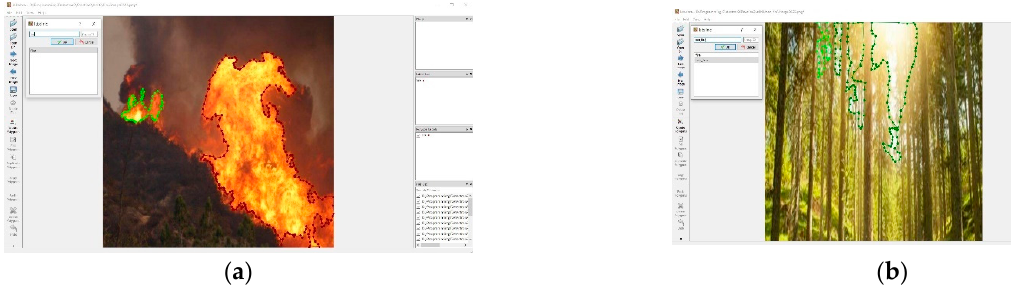
Figure 3. Image annotation; ( a ) fire, ( b ) non-fire.